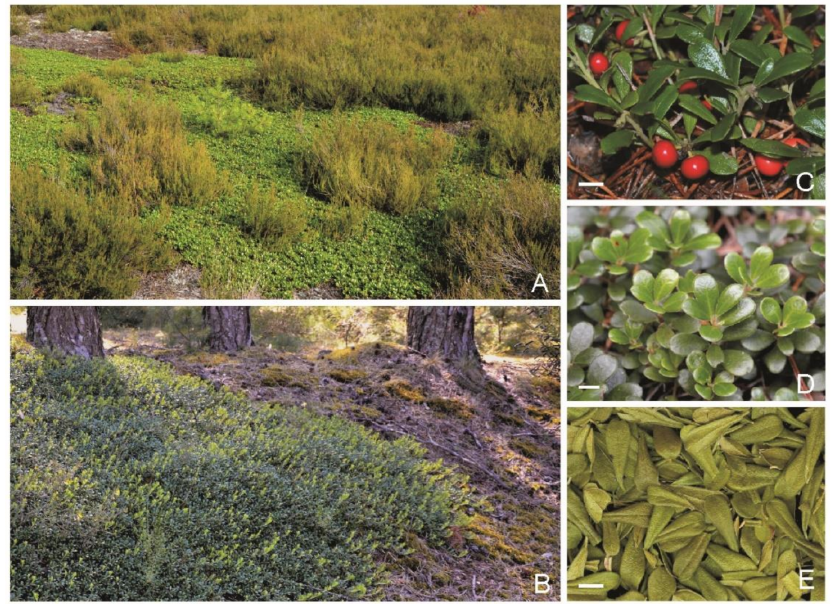
Figure 1. Arctostaphylos uva-ursi . ( A )—heathland population, ( B )—pine forest population, ( C )— fruiting individual, ( D )—one-year-old shoots, ( E )—raw material; lines indicate a length of 1